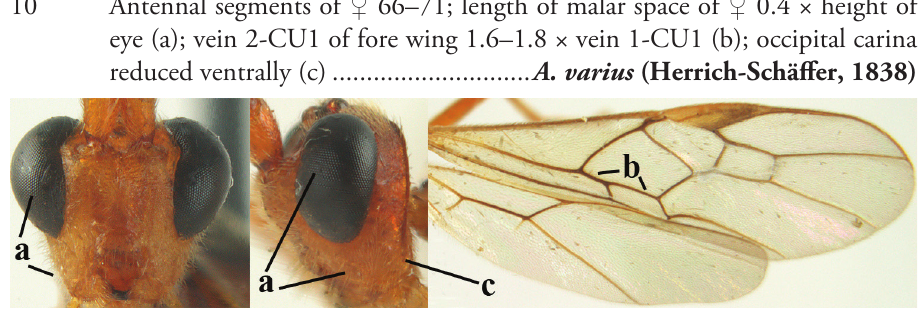
Antennal segments of ♀ 66–71; length of malar space of ♀ 0.4 × height of